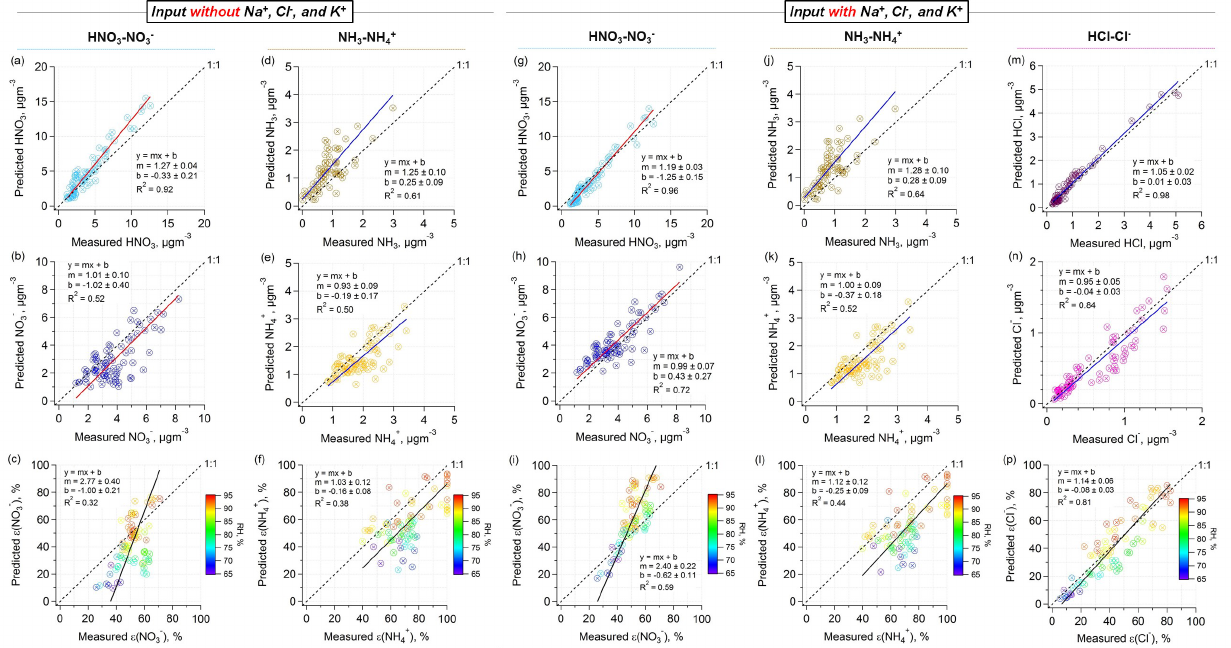
Figure 4. Intercomparisons of predicted and measured gas–particle phase partitioning for PM 2 . 5 particles for two scenarios: ISORROPIA-II input without (left) and with (right) Na + , Cl − (and HCl), and K + . The other input SO 2 − in the two cases. The PM 2 . 5 data for the last week during CalNex study are shown above. ODR fits are applied.